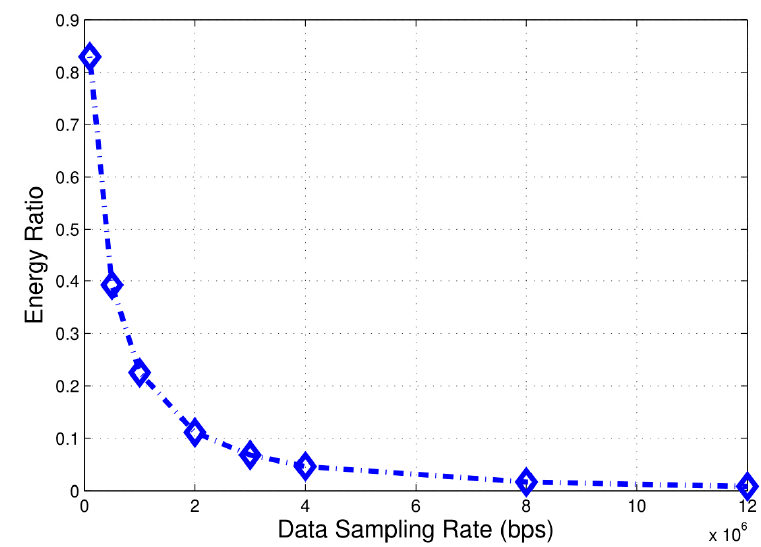
Figure 4. Energy saving ratio for different data sampling rates.